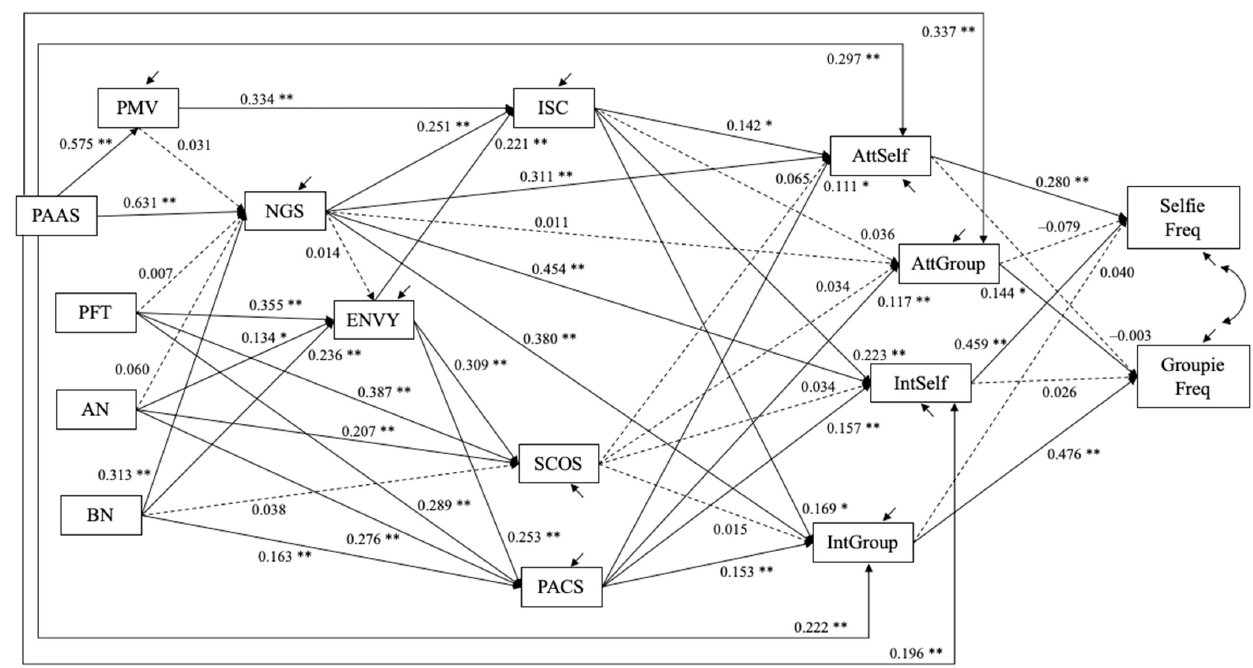
Figure 9. Study 3: Estimated structural equation model (Model II-1, N = 557). Unstandardized estimates are shown. Dashed line depicts path coefficients for which p > 0.10; † p < 0.08; * p < 0.05; ** p < 0.01. The following covariances are allowed in the model but not shown in the figure: perceived mating value (PMV) and three eating disorder var- iables (PFT, AN, BN) are allowed to covary with one another; the residuals for intrasexual competition (ISC) and social comparison (SCOS, PACS) are allowed to covary with one another; the residuals for attitudes toward and intention to take selfies and groupfies (Att- Self, AttGroup, IntSelf, IntGroup) are allowed to covary with one another.